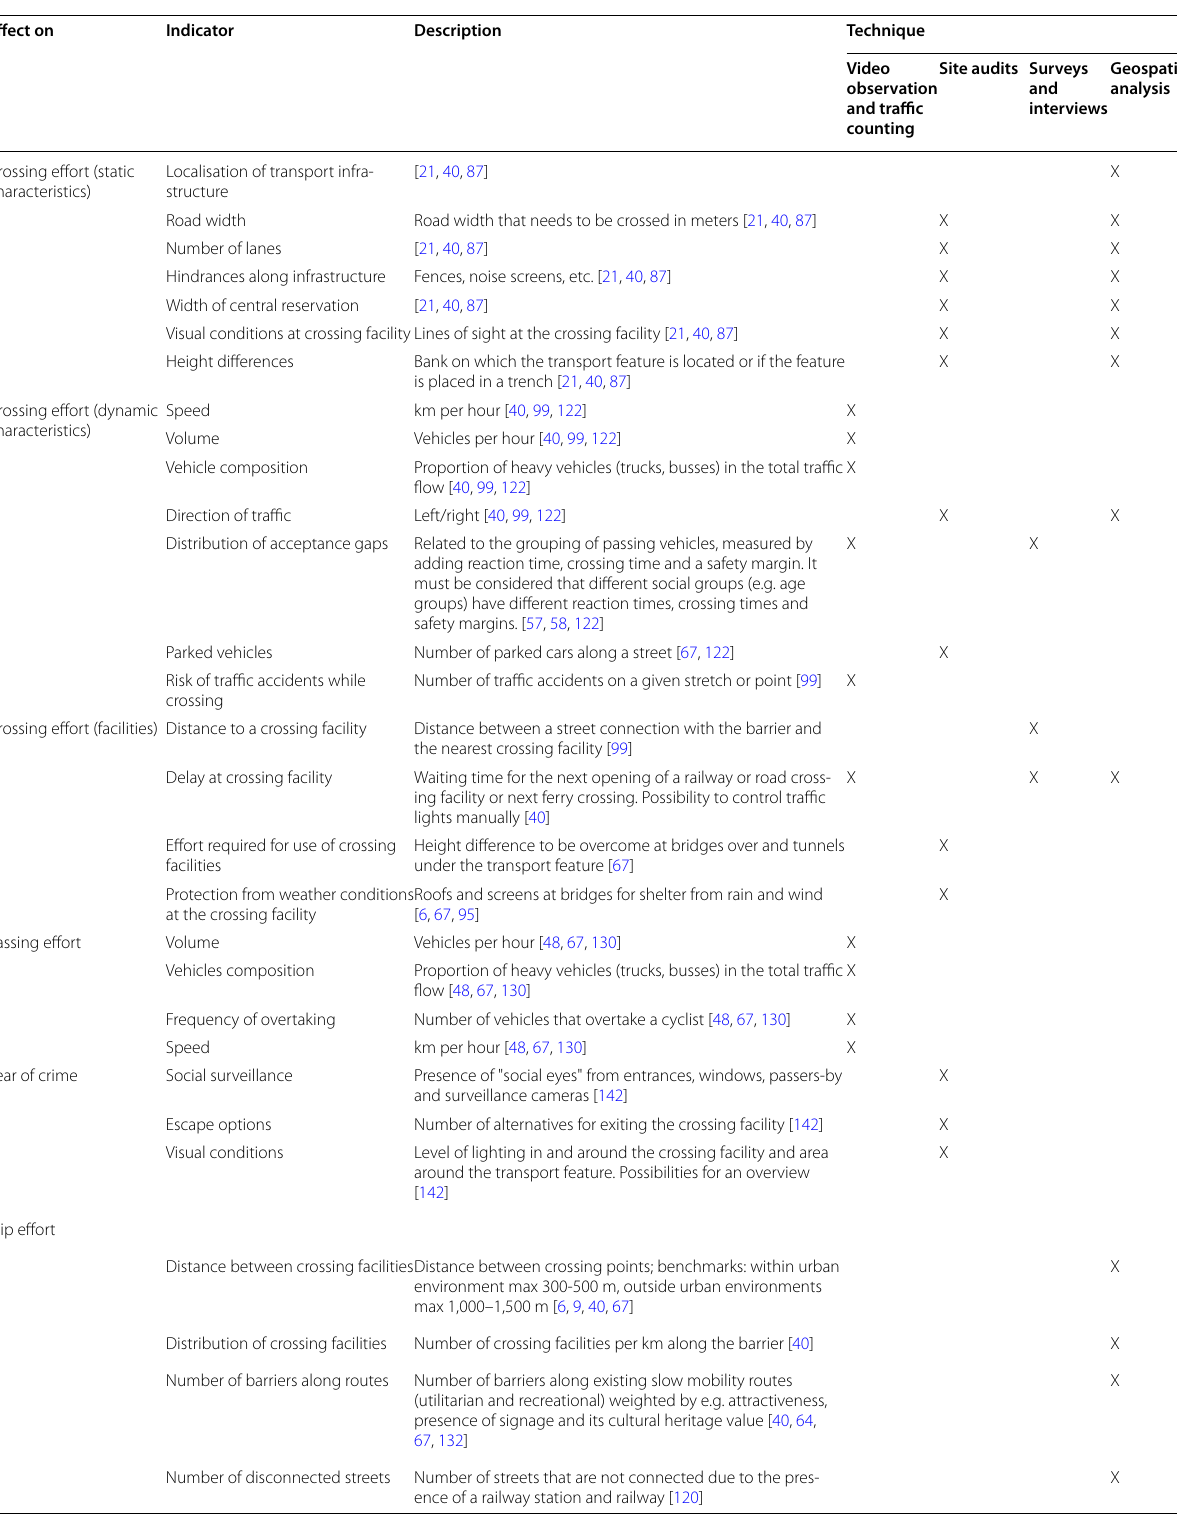
Table 8 Indicators of direct barrier